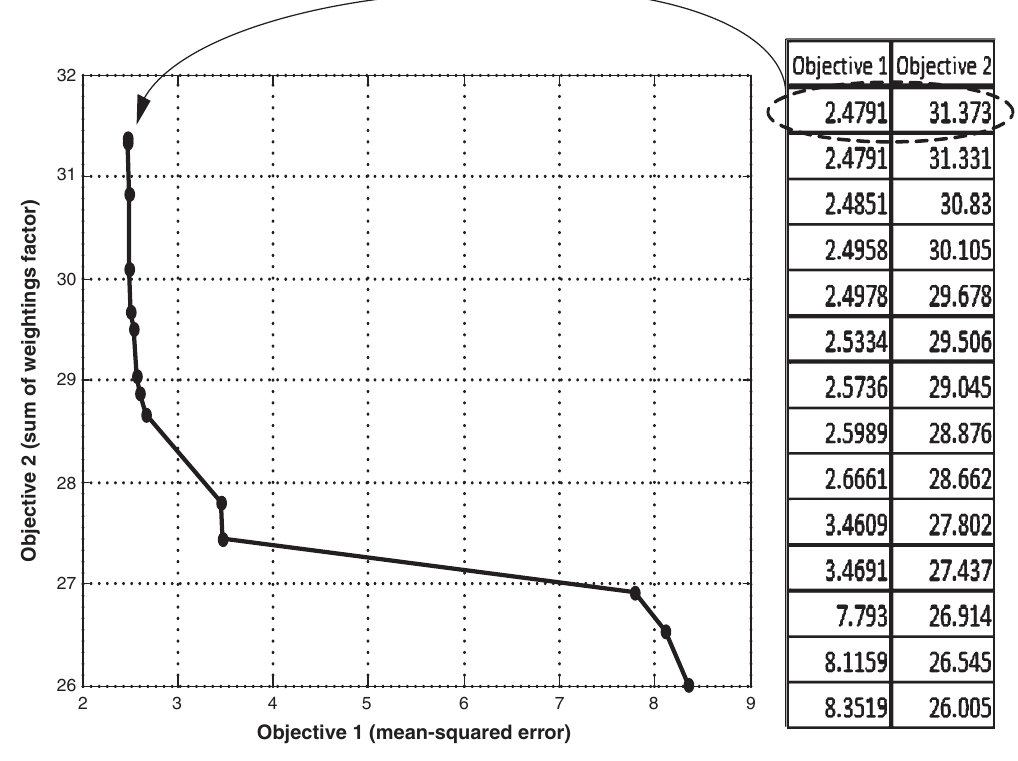
Fig. 9. MOGA optimization results.